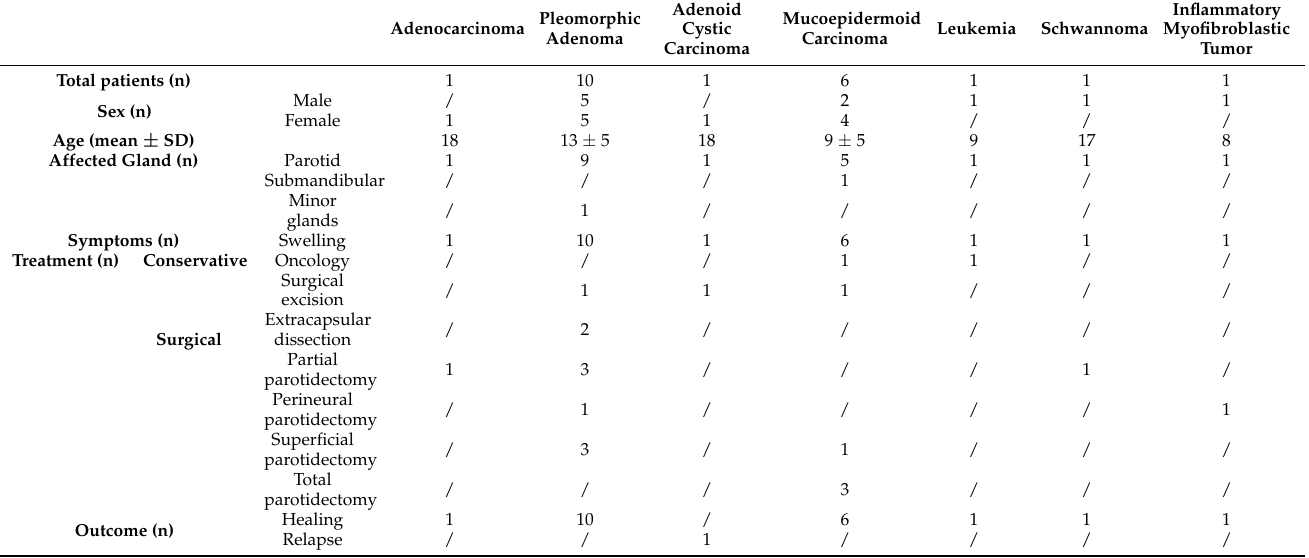
Table 5. The oncologic